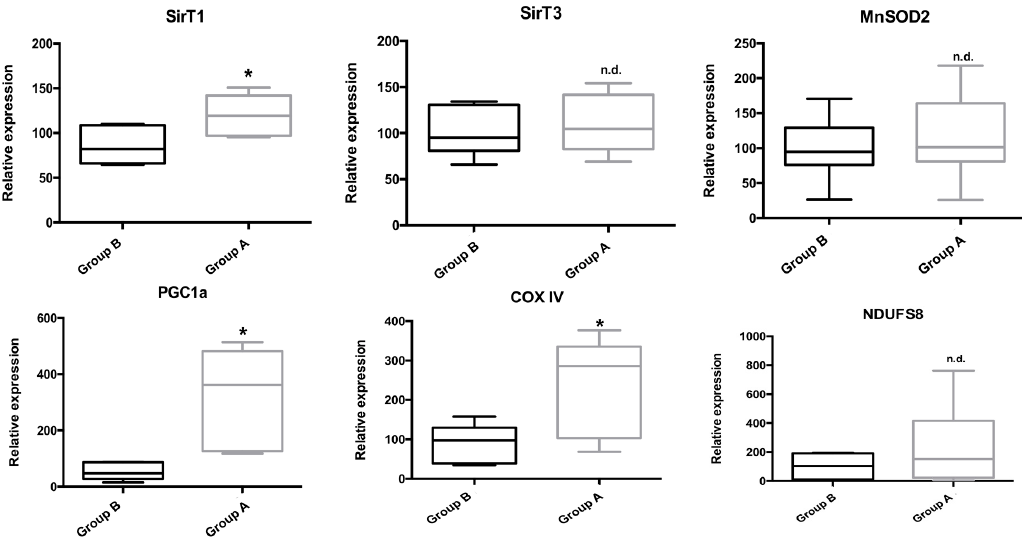
Figure 11. The effect of BBR addition in the preservation solution before ischemia on the gene expression of Sirt 1 and 3, PGC-1 α , MnSOD2, COX IV and NDUFS8 as evaluated by qPCR. Tissue samples were obtained from animals sacrificed after 12 h of hepatic exposure to preservation solution and 1 h of reperfusion, as described in the Materials and Methods Section. Control animals were sham operated. I/R livers (Group B) had a reduced gene expression of SirT1, the nuclearly-encoded mitochondrial respiratory complex IV subunit IV (COX IV) and PGC-1 α , which were prevented by BBR pre-treatment (Group A). No differences were found in the gene expression of SirT3, the mitochondrial antioxidant protein MnSOD2 and the mitochondrially-encoded mitochondrial respiratory complex I iron-sulfur protein 8 (NDUFS8). Boxes represent the means ± 5–95 percentile of an n = 6 different experiments. * indicates a statistically-significant difference ( p < 0.05) against Group B; n.d., no difference.